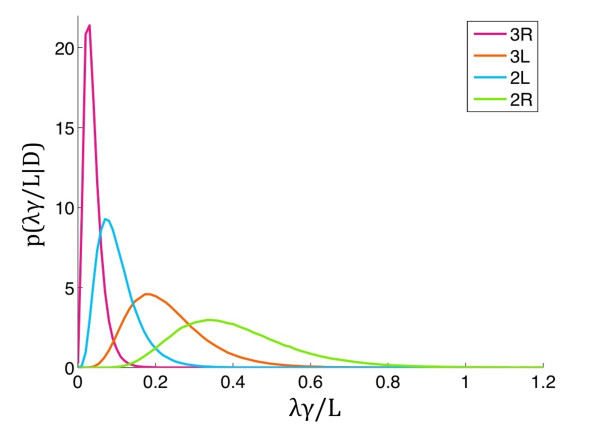
Chromosome arm-specific differences in rates of accumulation of disrupted gene blocks. X axis shows rates of accumulation of disrupted blocks per region length per unit length, z = (λj(diff) γj(diff))/L. Y axis shows a density of p(z|D); p--density, D--data.